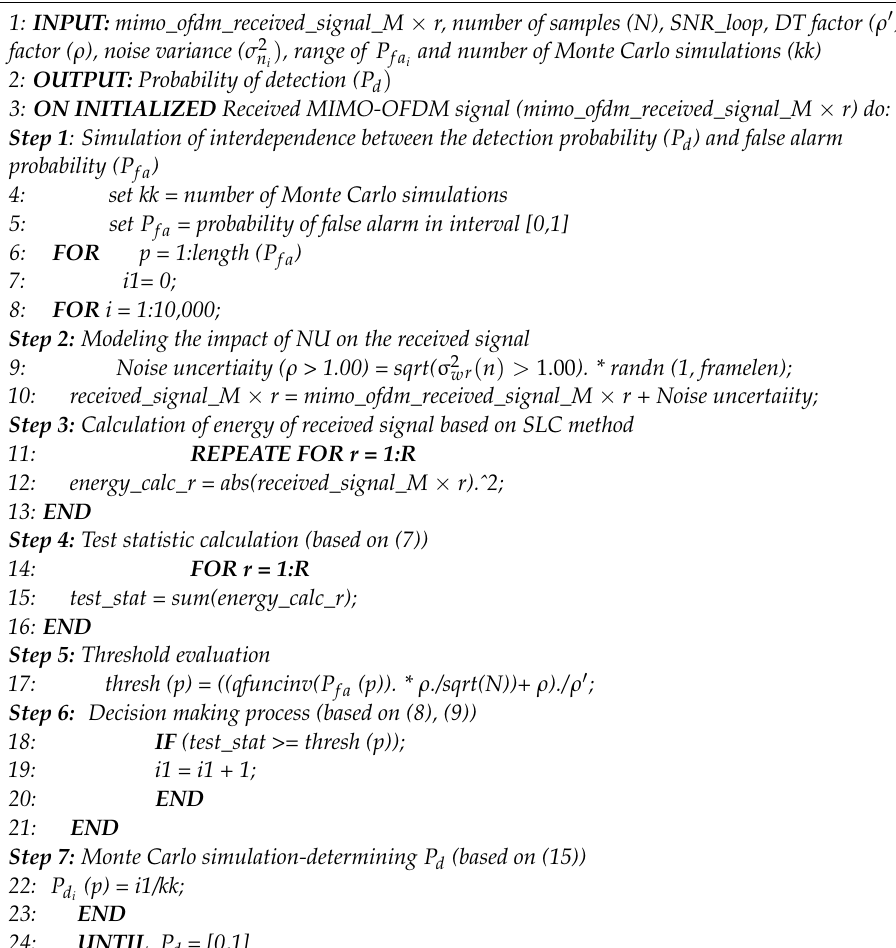
Algorithm 1. The pseudocode of the proposed ED